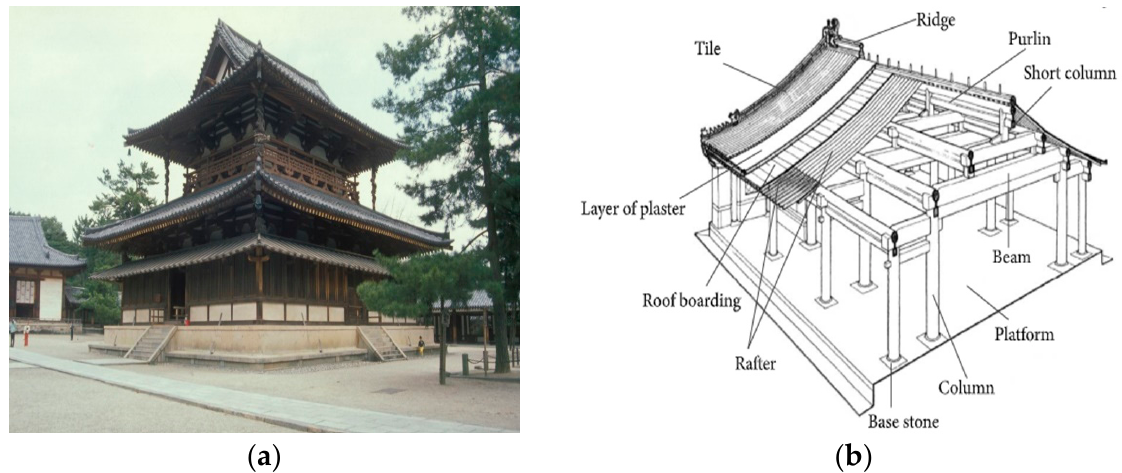
Figure 4. ( a ) A post and beam structure [9]. ( b ) A 3D drawing for a frame from a post and beam structure with its details [21].